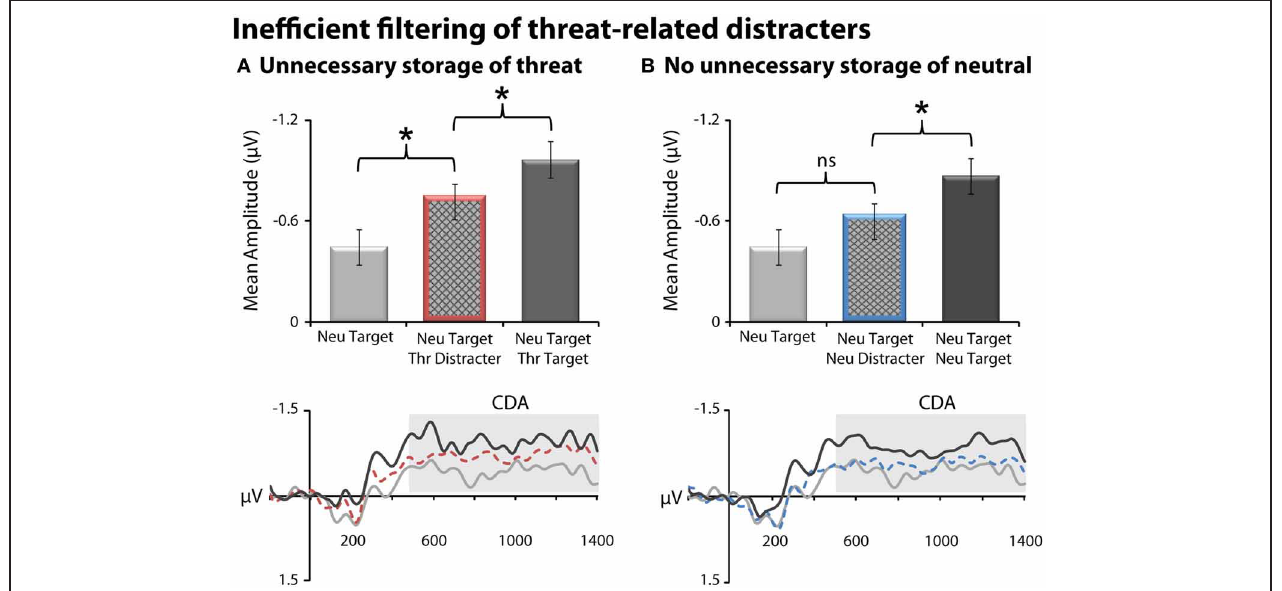
FIGURE 3 | Threat-related distracters were inefficiently filtered from working memory, as indexed by contralateral delay activity (CDA). (A) Threat distracters. Mean CDA amplitude was significantly increased (i.e., more negative) on trials with a threat-related distracter (red bar) (NT1FD1) compared to those with a single neutral target (light gray) (NT1). On average, subjects were able to filter threat-related distracters, albeit inefficiently; mean CDA amplitude was significantly decreased on trials with a threat-related distracter (NT1FD1) compared to those with two physically-matched targets (dark gray) (NT1FT1). CDA waveforms for the three conditions are shown at